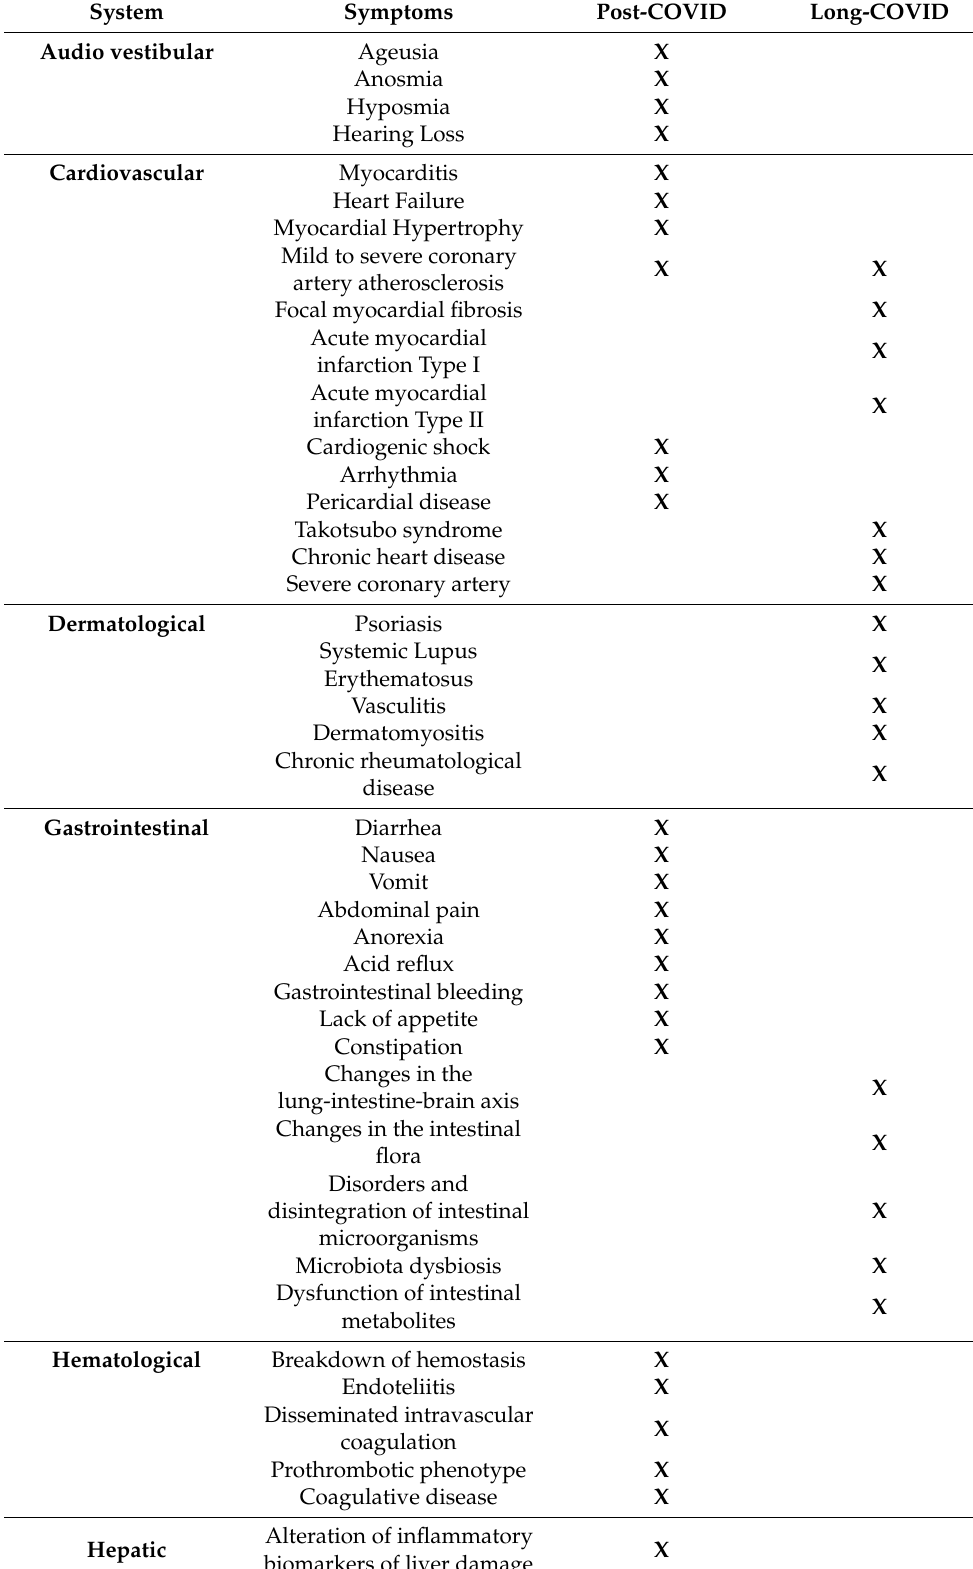
Table 2. Classified long-COVID and Post-COVID symptoms summarized as per human body